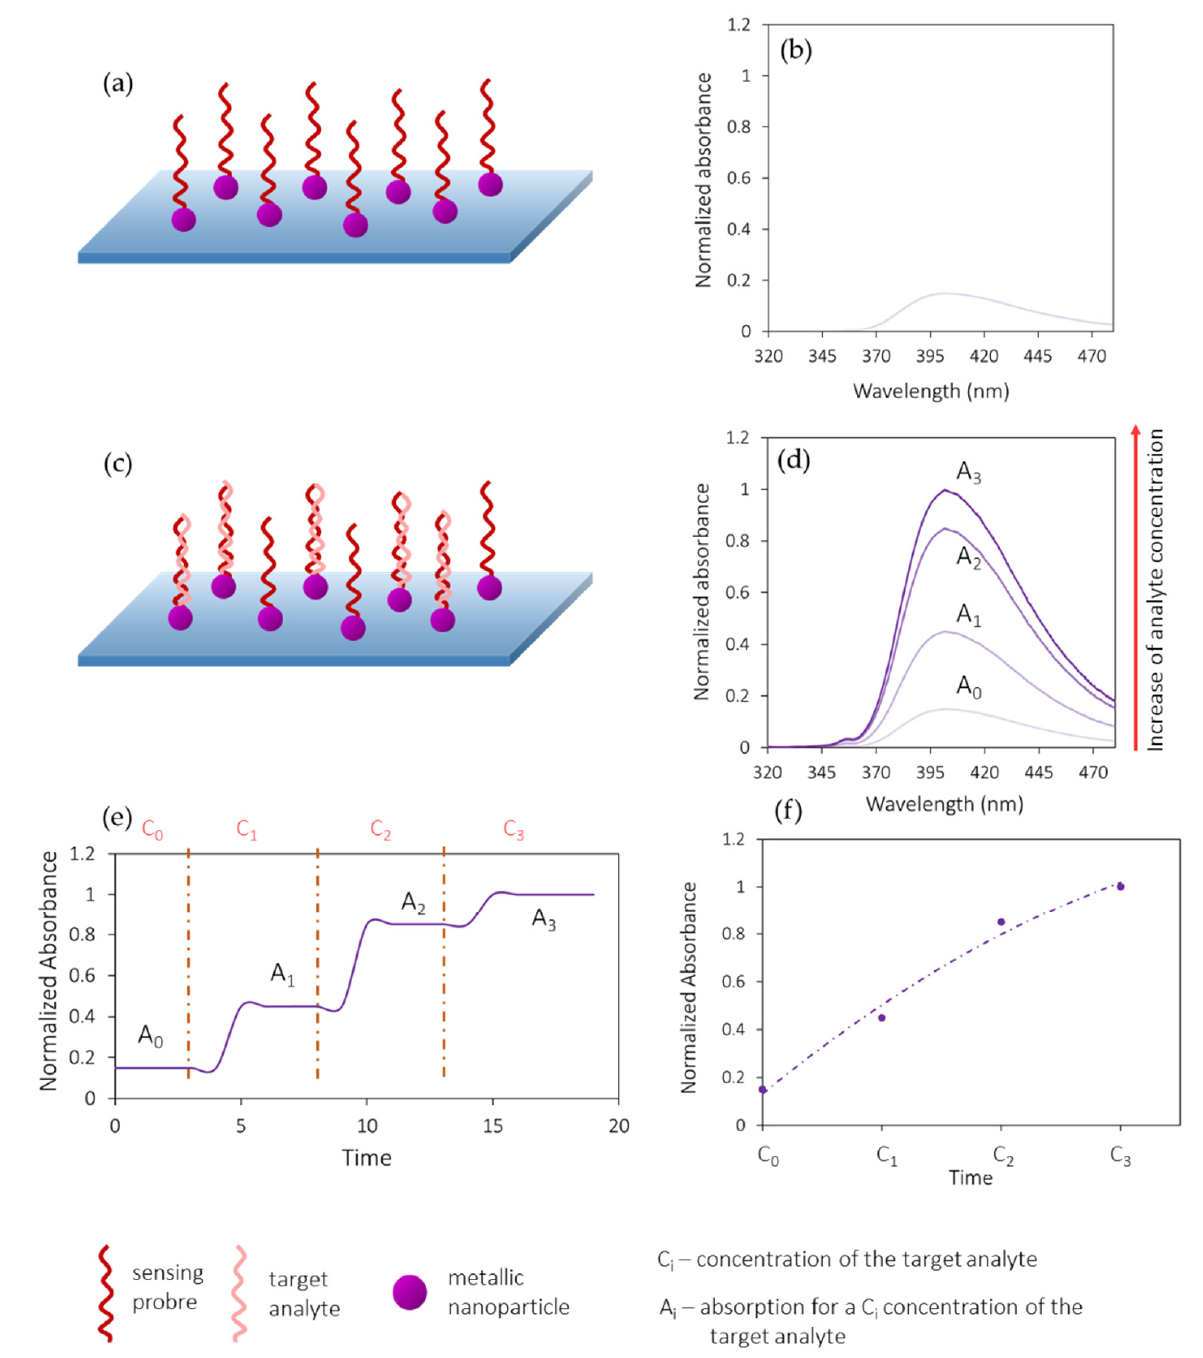
Figure 5. Working principle of an absorption-based optical fiber biosensor. ( a ) Fiber coated with a metallic nanoparticle- labelled bioreceptor. ( b ) Original absorption spectrum centered at a determined wavelength. ( c ) Increasing bioreceptor— analyte binding, which increases the absorption at that wavelength ( d ). ( e ) Dynamic response and ( f ) calibration curve of the optical fiber biosensor. The purpose of this schematic is to show the generic behavior of this kind of sensors, so the graphs do not correspond either to experimental or simulated data, or to any existing